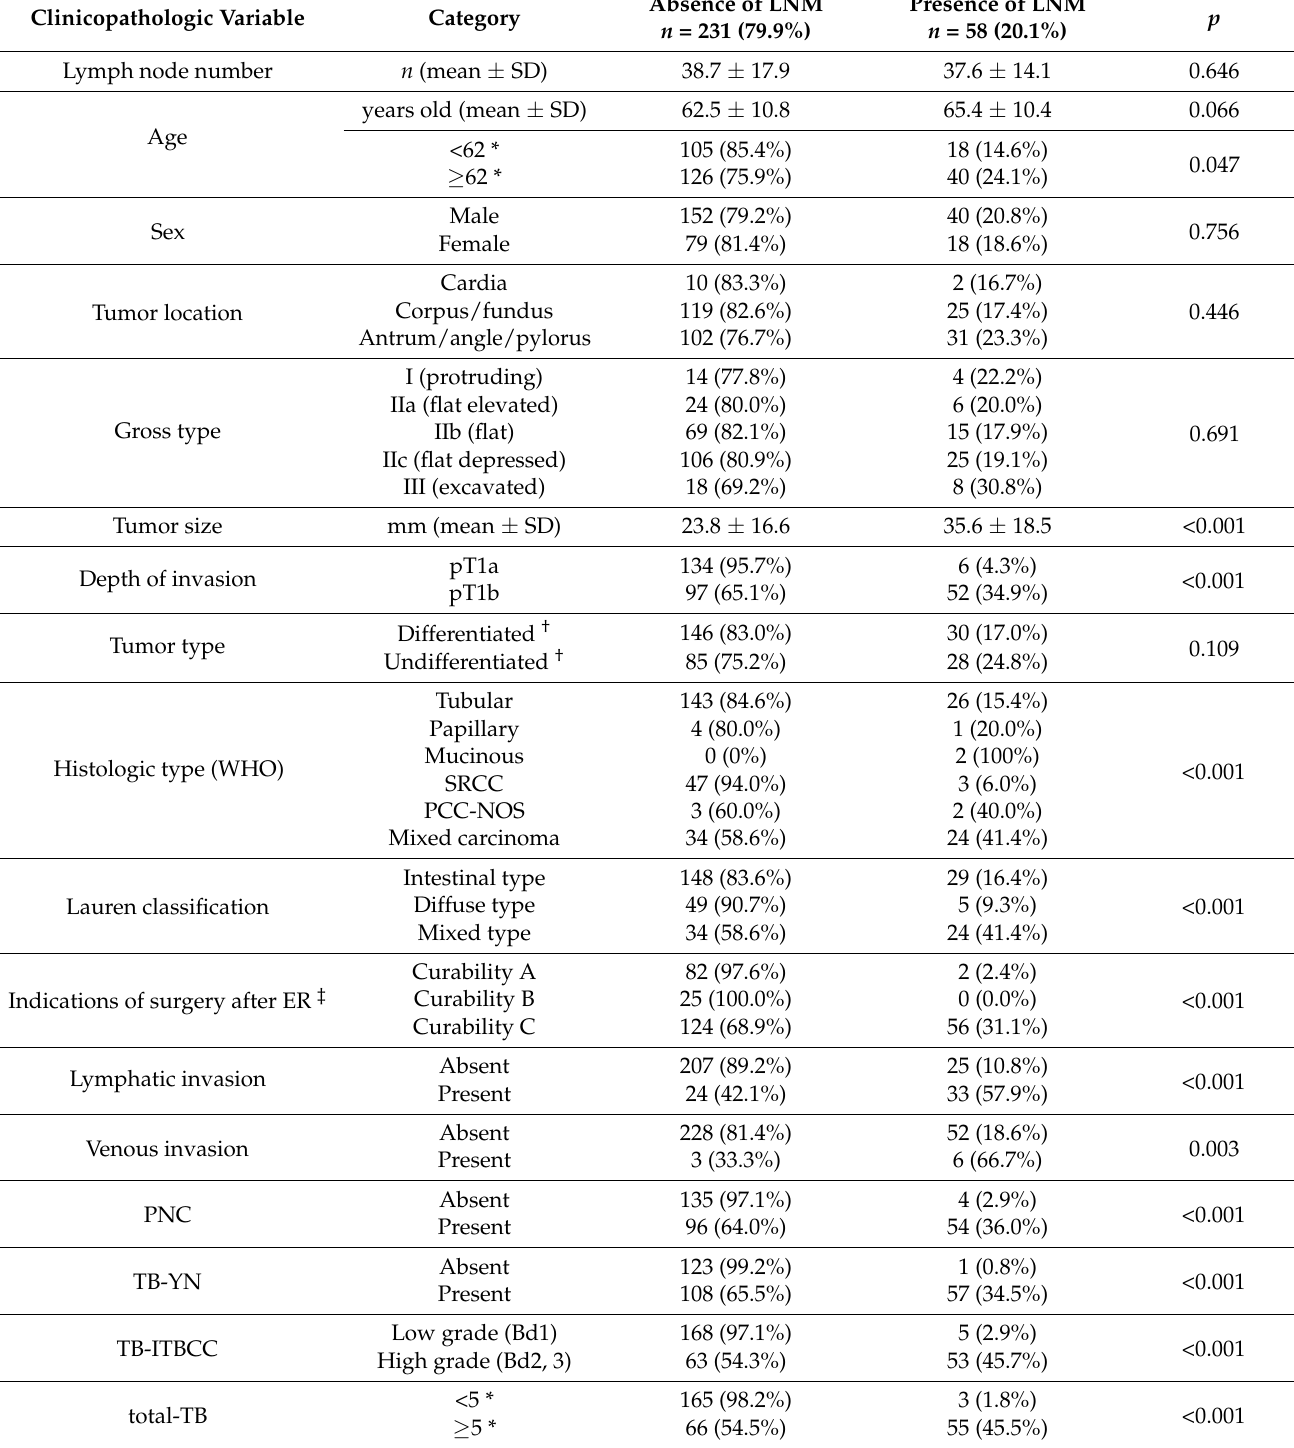
EGC (Table 1), intramucosal EGC (Table S1) and undifferentiated-type dominant EGC (Table S2). Conversely, TB-equivalent SRC, (i.e., TB cells morphologically equivalent with SRC only) was not associated with LNM (Table 2). Table 1. Clinicopathological characteristics of all early gastric